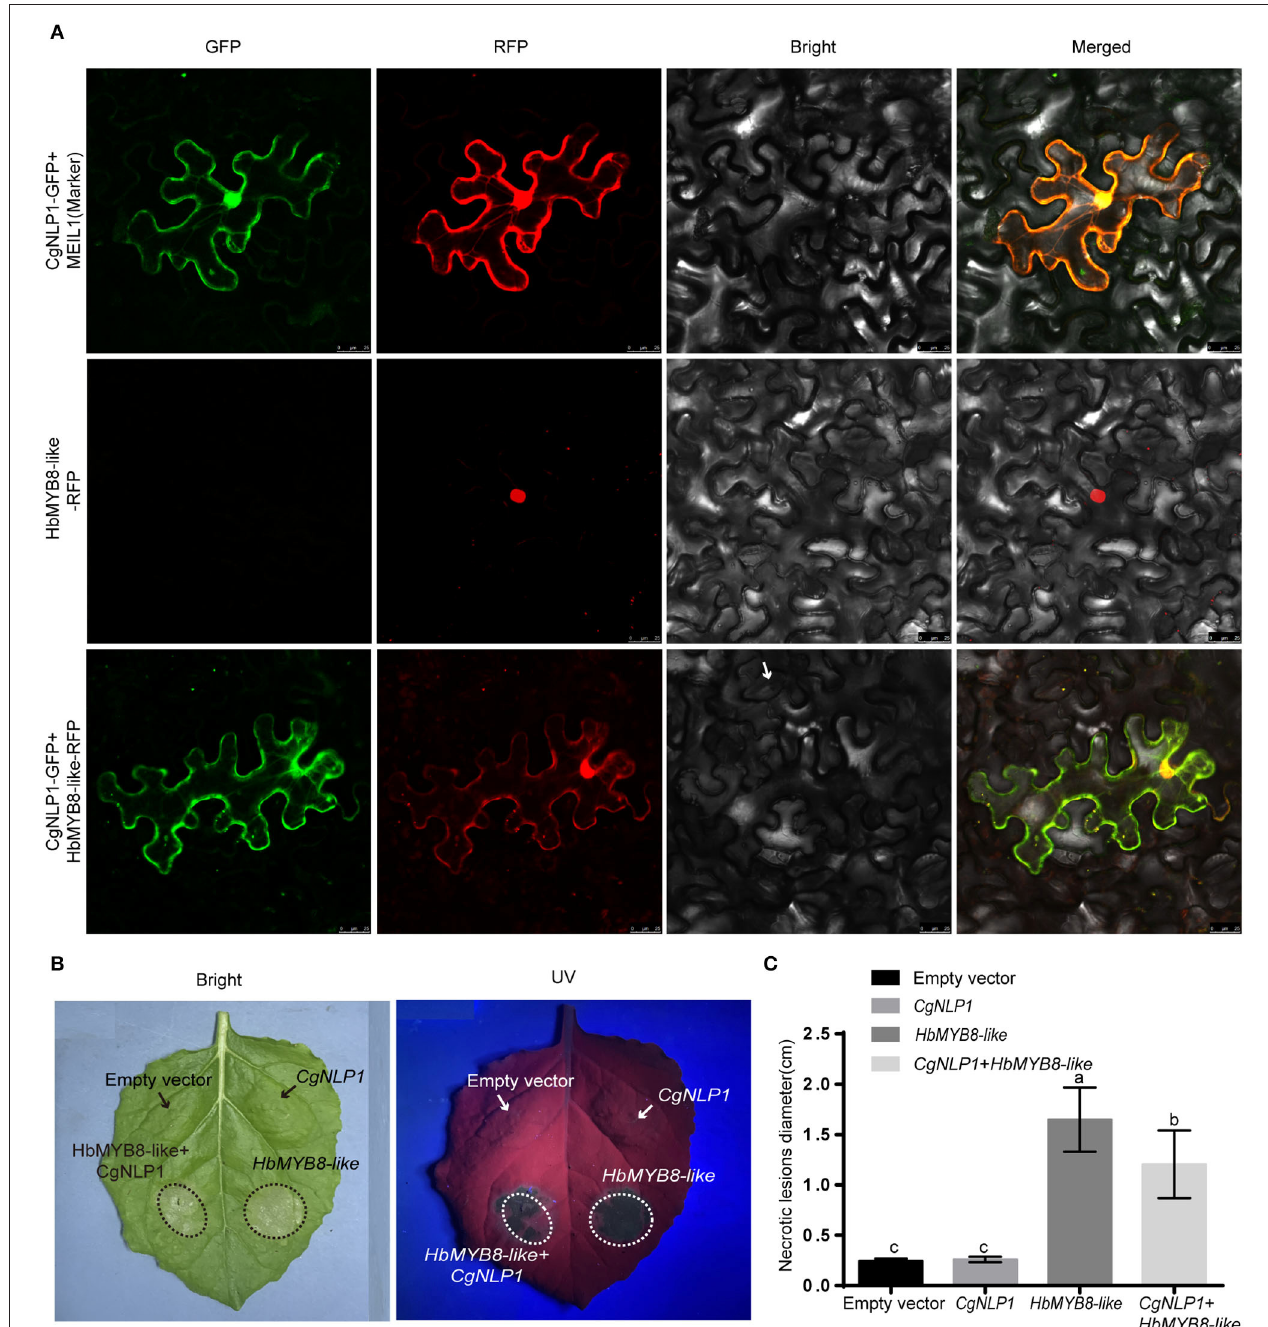
FIGURE 8 | CgNLP1 repressed nuclear accumulation of HbMYB8-like and inhibited necrosis induced by HbMYB8-like. (A) CgNLP1 repressed nuclear accumulation of HbMYB8-like. Scale bar = 25 µ m. (B) CgNLP1 inhibited necrosis induced by HbMYB8-like. (C) Statistical analysis of necrosis diameter in tobacco leaves. Data are shown as the means ± SD from three independent experiments, and columns with different letters indicate a significant difference ( P < 0.05).